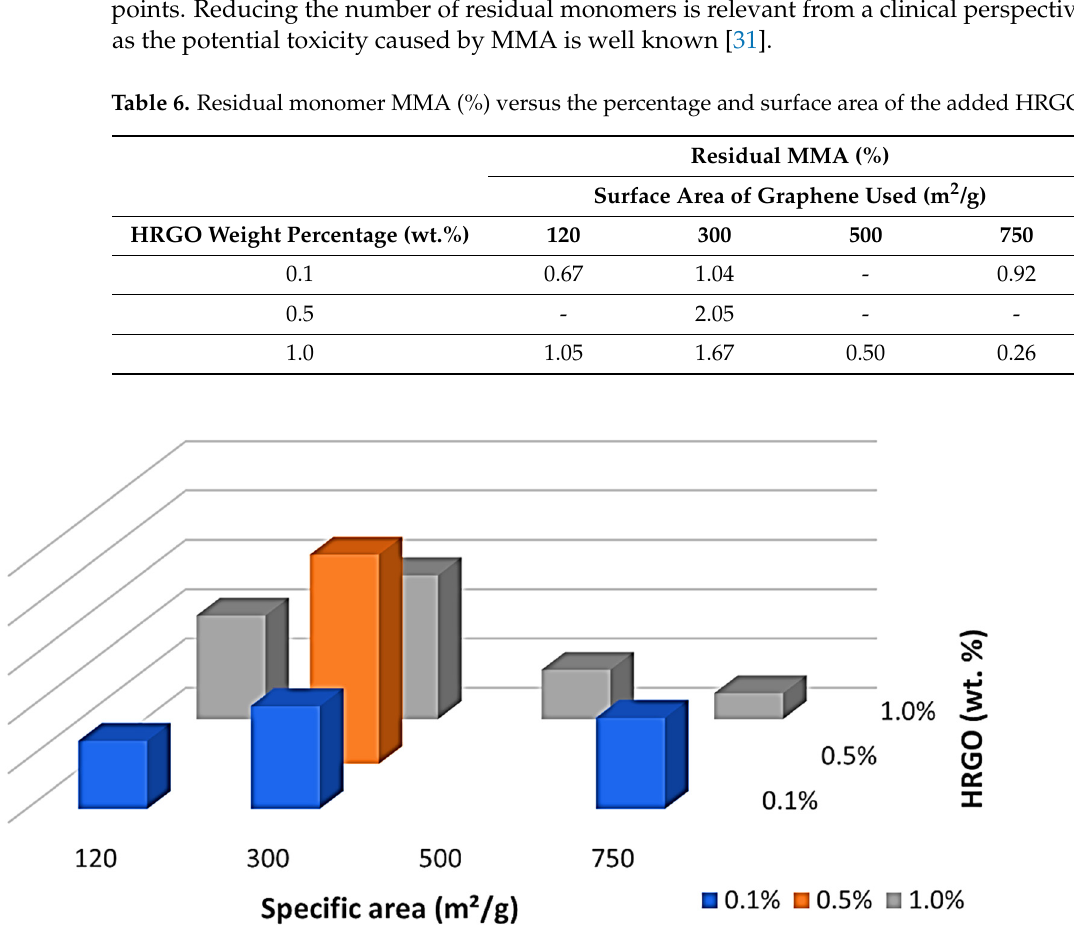
Figure 2. Residual monomer (MMA) versus specific area and percentage (blue = 0.1%, orange = 0.5%, and grey = 1.0%) by weight of HRGO.